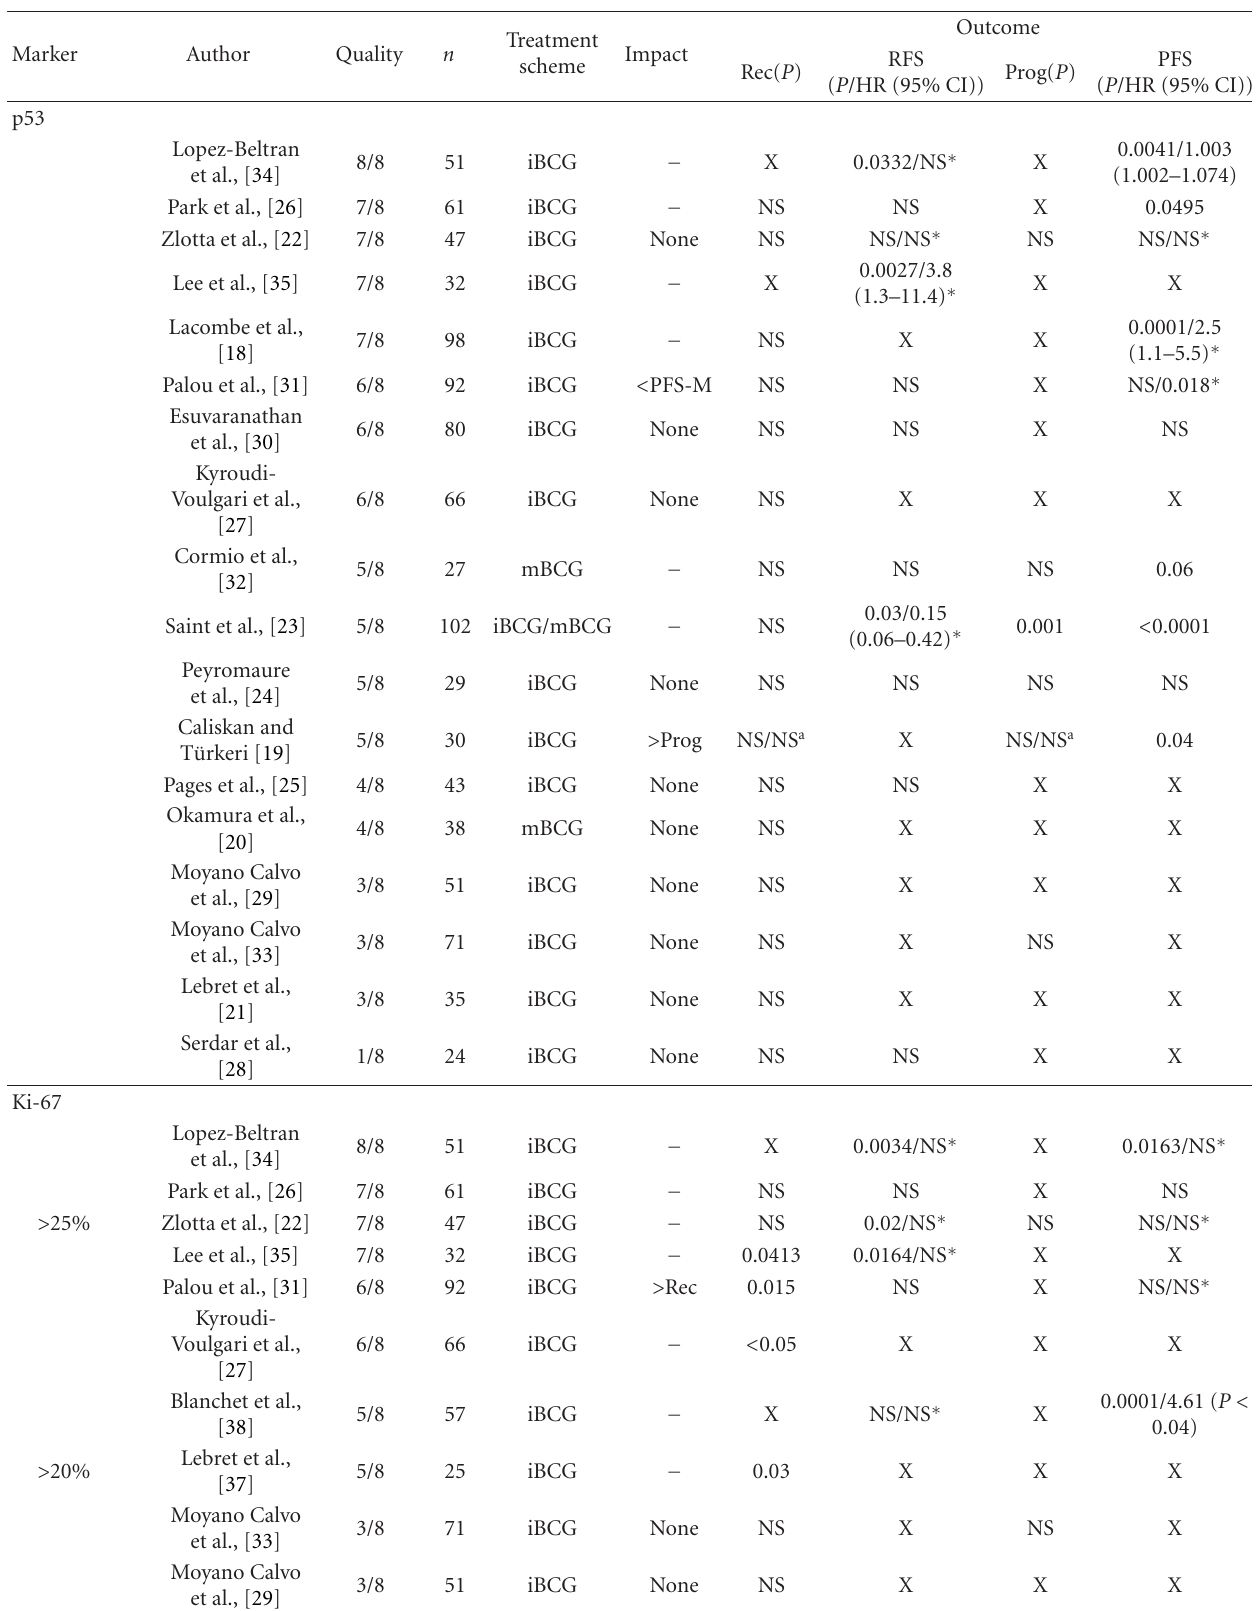
Table 1: Tumour-associated markers predicting BCG treatment outcome. The markers are ordered from the most studied to the less, and, within each marker, the studies are ordered by quality